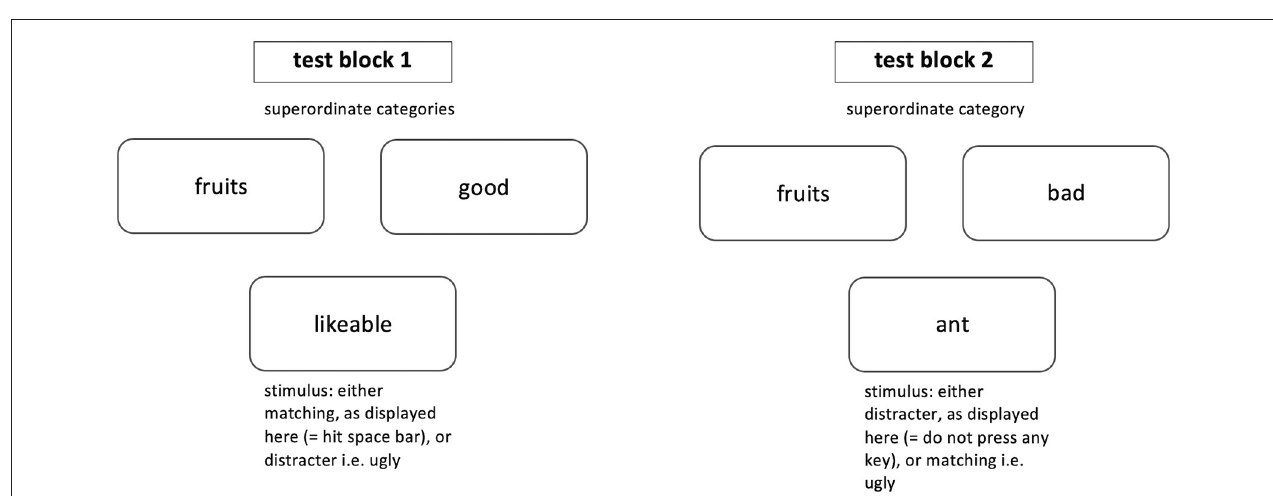
FIGURE 2 | Test blocks as they may appear in a GNAT. The superordinate categories stay the same throughout one test block, whereas stimuli change after a deadline is reached or the space bar was pressed.